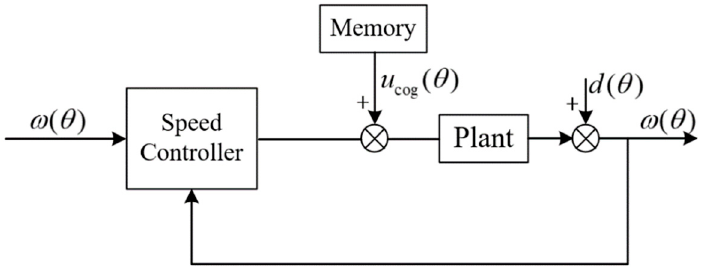
Figure 6. System diagram after ILC